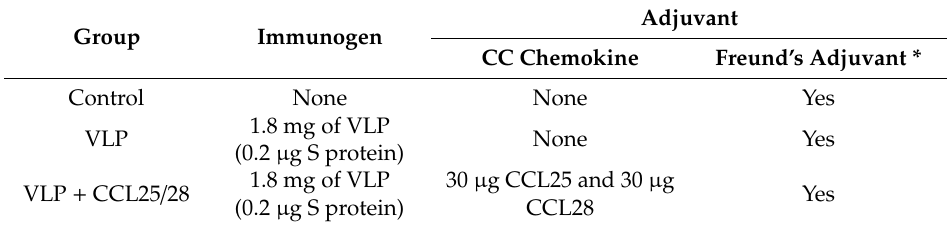
Table 1. Vaccine formulation and immunization program.